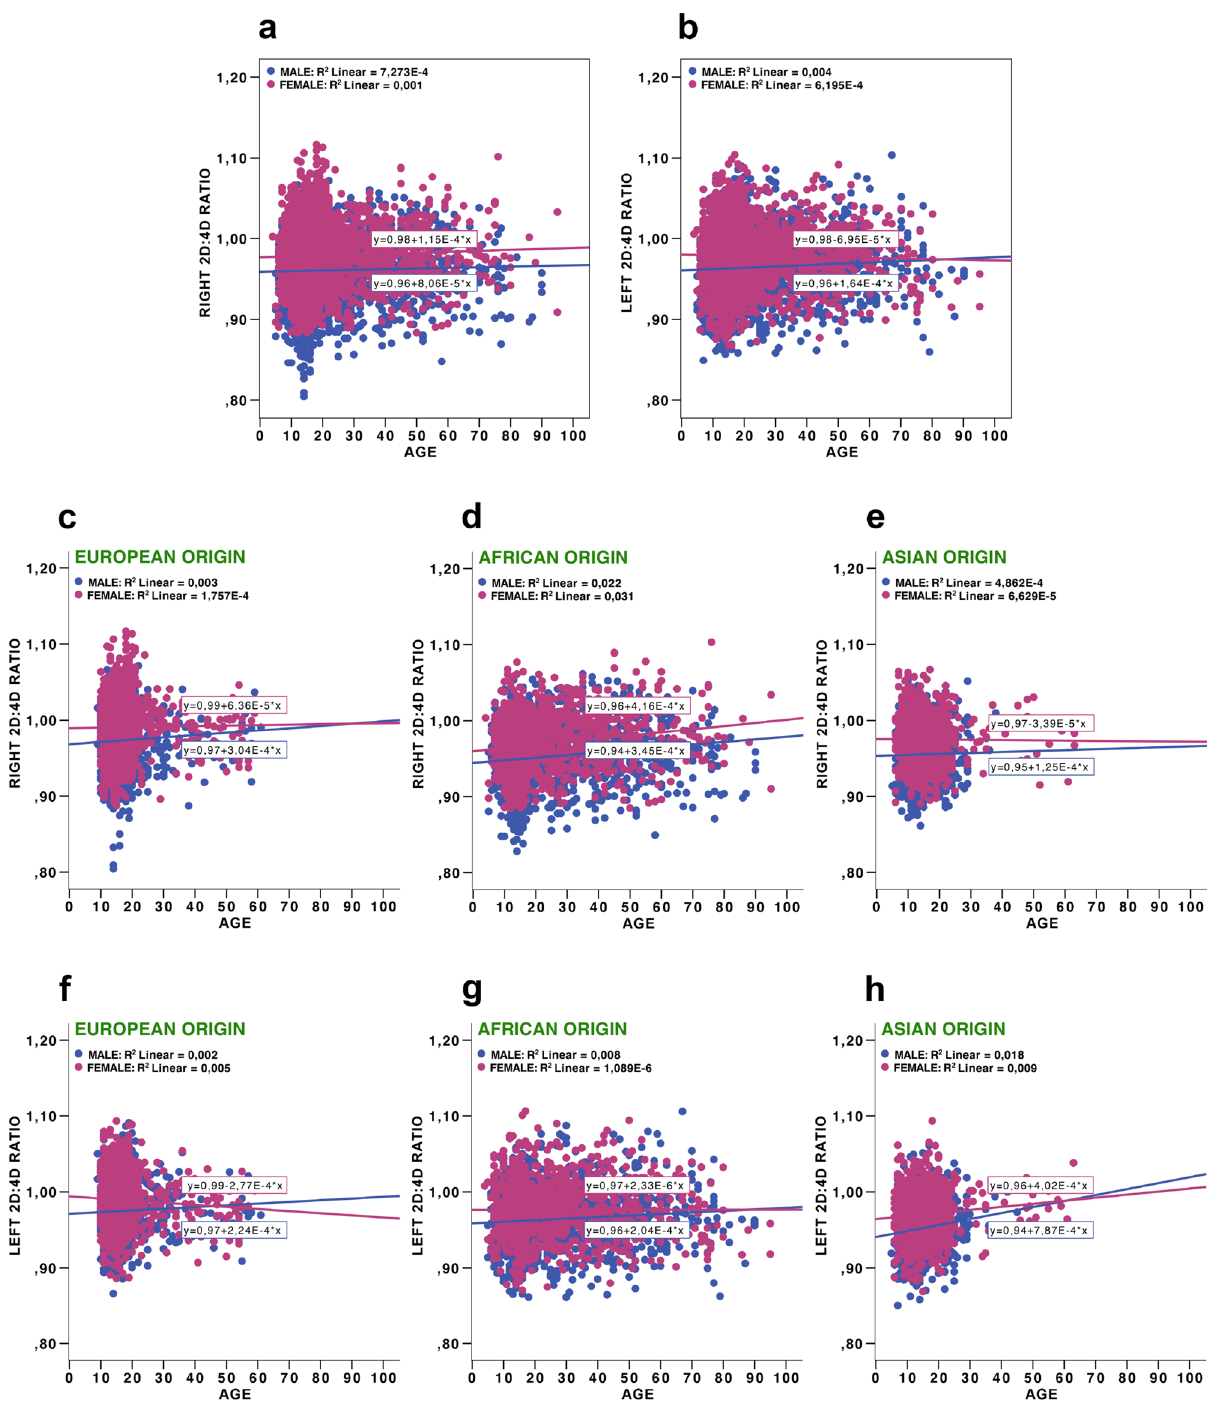
Figure 4. Right and left 2D:4D ratios to age: right 2D:4D ratio to age in total sample ( a ), left 2D:4D ratio to age in total sample ( b ), right 2D:4D ratios to age in three populations (European origin ( c ), African origin ( d ), Asian origin ( e )), left 2D:4D ratios to age in three populations (European origin ( f ), African origin ( g ), Asian origin ( h lengths in boys and girls do not make the sex effect on 2D:4D less statistically significant. The effect size of sex was higher than the average digit length in all cases, and height (in the case of Europeans, less than 30 years of age). The theory according to which the sex difference in 2D:4D has been driven by the sex difference in digit length may have arisen from a misunderstanding and incorrect assumption ignoring the human growth pattern trajectory. The stability of 2D:4D may be an example of homeostasis of form, and our data completely support J. Manning and B. Fink’s idea 30 . Another important conclusion is that the degree to which androgenisation (2D:4D